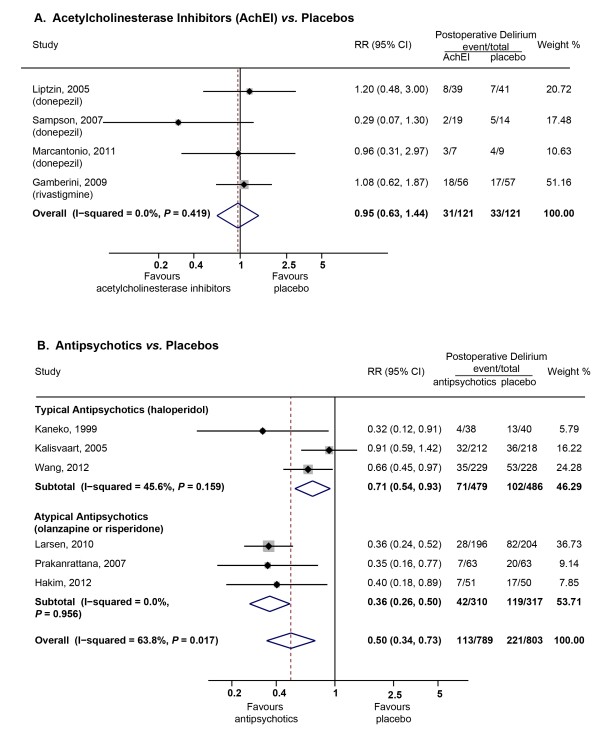
Summary relative risks (RRs) for the incidences of postoperative delirium in trials testing the role of acetylcholinesterase inhibitors (AchEI) (A) and antipyschotics (B).